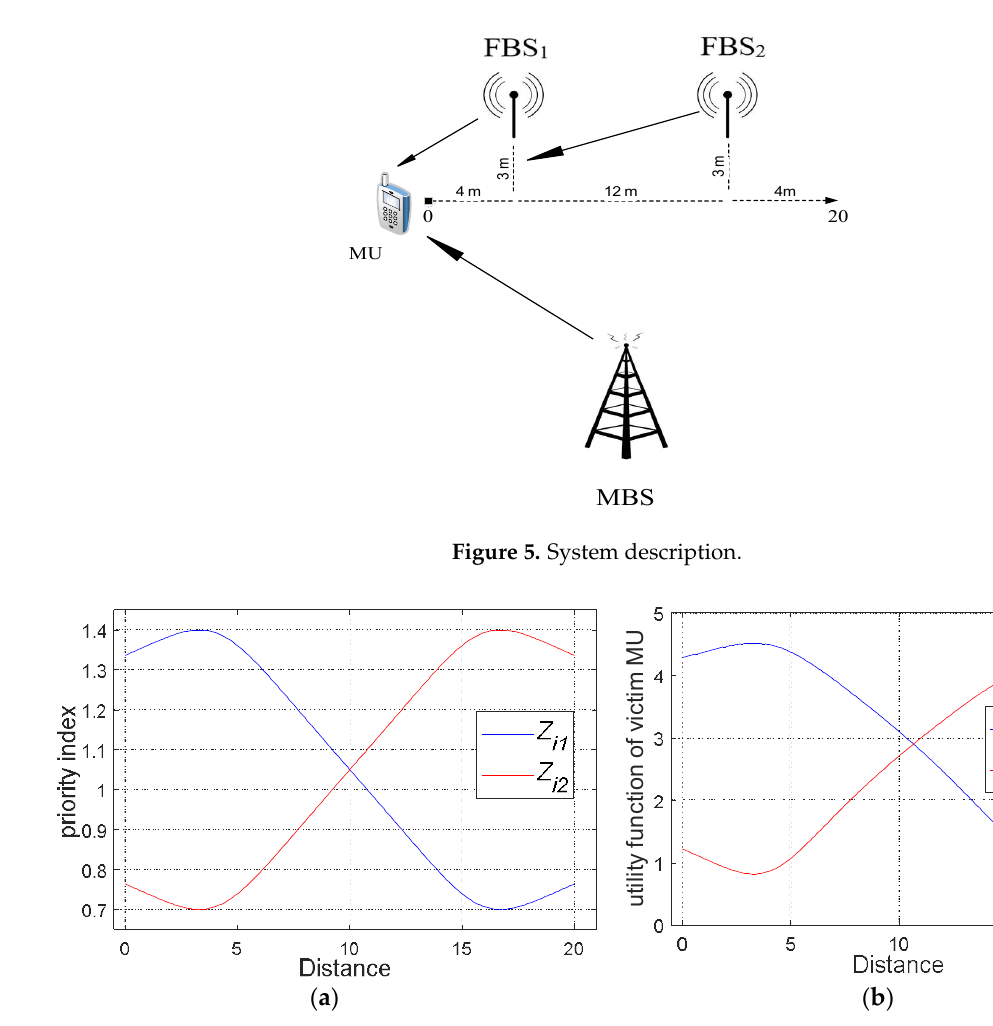
Figure 6. Priority index ( a ); utility function of the macro user ( b ).